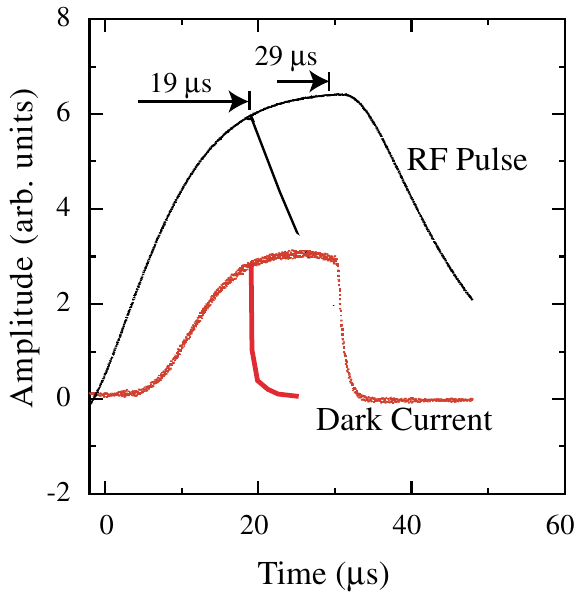
FIG. 2. (Color) Pulse shapes for long and short rf